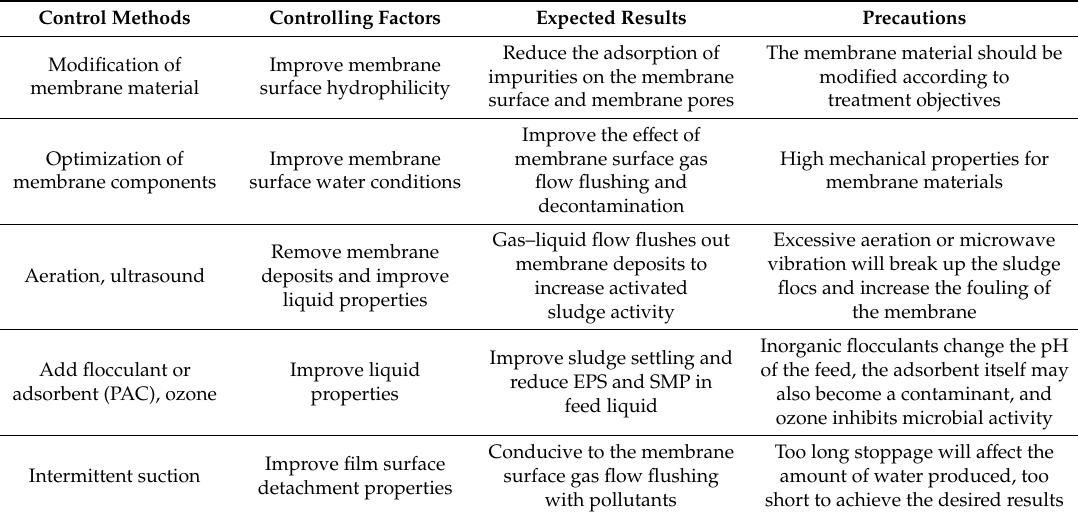
Table 3. Comparison of membrane fouling control